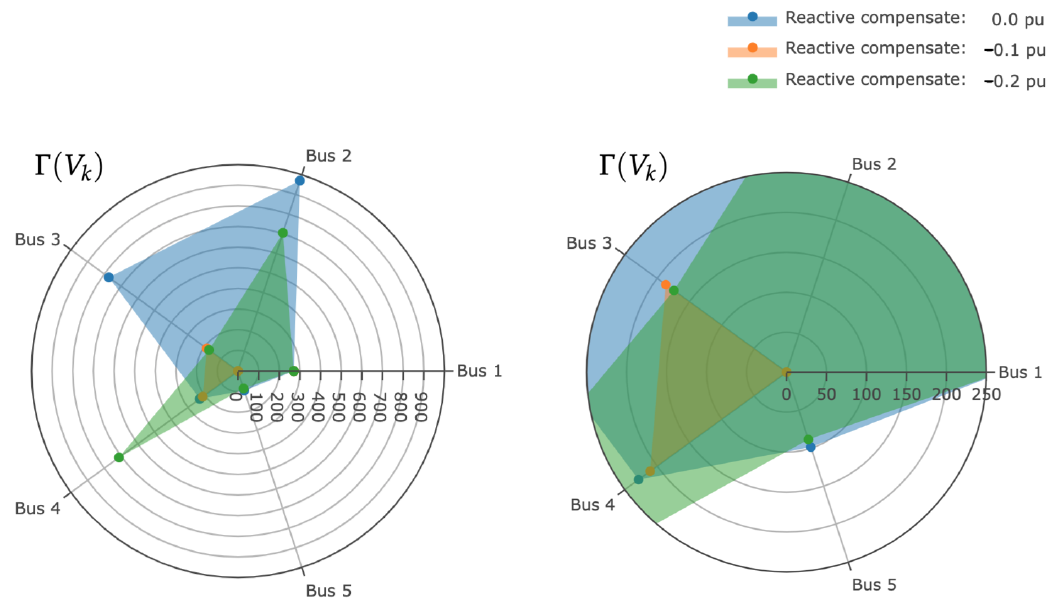
Figure 2. The variation of Γ indicating voltage collapse risk on IEEE 5-bus test distribution system.